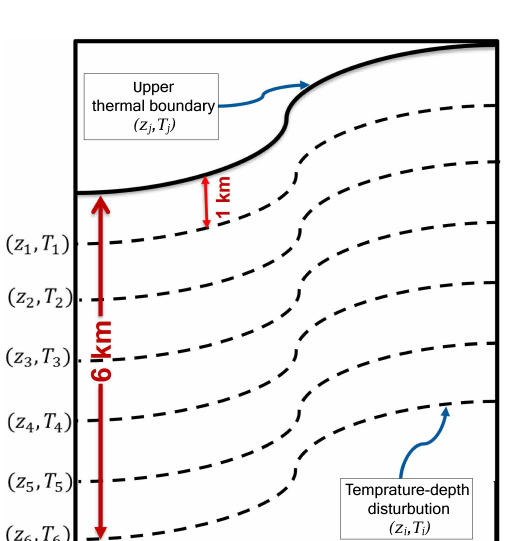
heat flow and bottom-hole temperature measurements. As bottom-hole temperatures therefore depend on the absolute depth of the drilled well, the derived average geothermal gra- dients vary accordingly. Our goal was to show (1) that there is no such thing as one average geothermal gradient and (2) that the latter is subject to variation in response to depth and structural